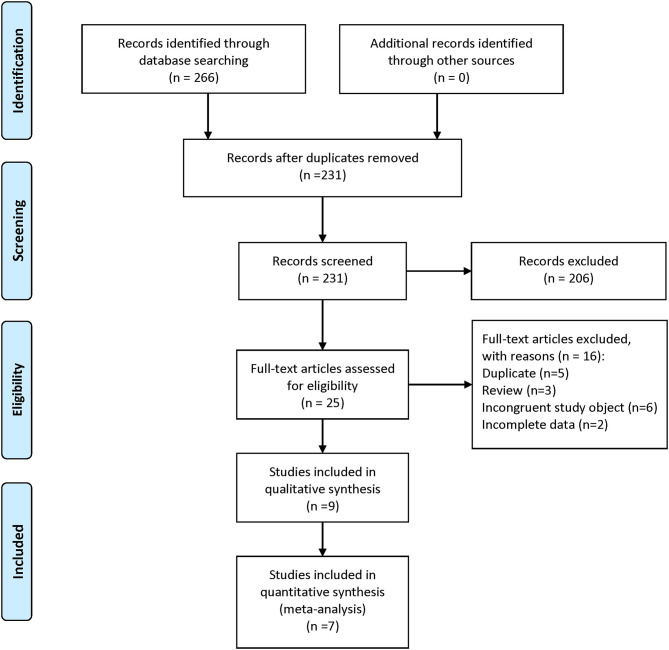
Flowchart of search strategy and study selection according to the 2009 PRISMA guidelines.